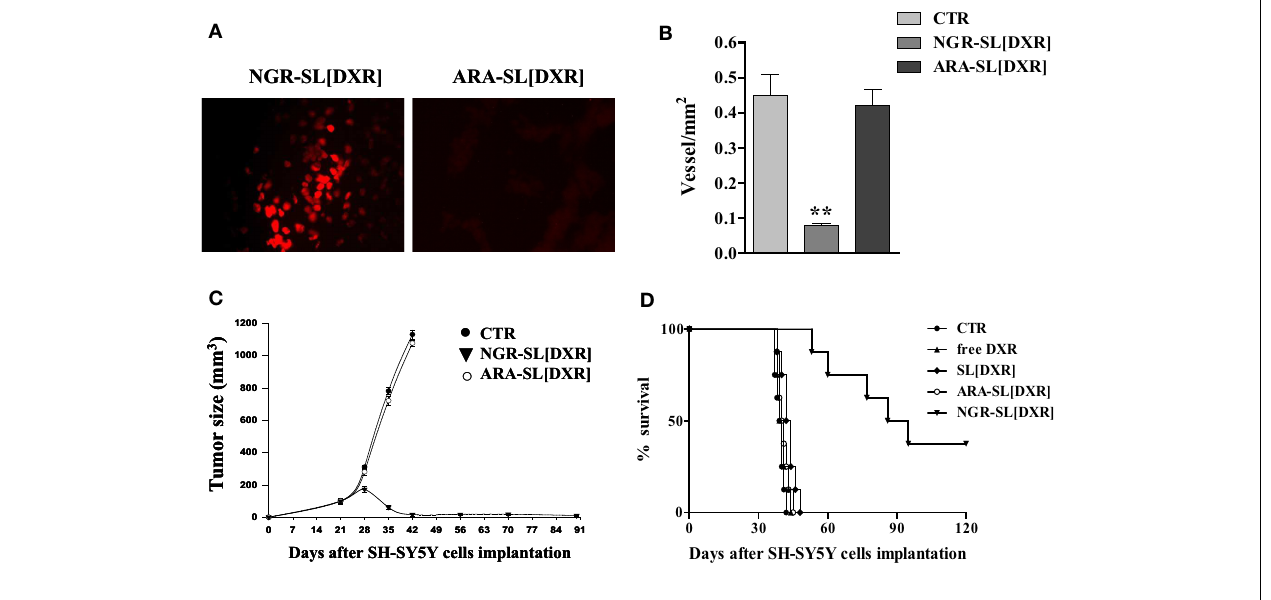
consisted of DXR administered either free (free DXR) or encapsulated in untargeted [SL(DXR)] and either NGR-targeted [NGR-SL(DXR)] or miss-matched peptide ARA-targeted [ARA-SL(DXR)] nanocarriers. Control mice (CTR) received HEPES-buffered saline. (B) Tumor vessels density inhibition after NGR-targeted liposomal DXR treatments. Orthotopic tumors, at day 36 from CTR and from both NGR- and ARA-targeted, DXR-treated groups, were sectioned and stained with an antibody to factor VIII to count blood vessels. Each bar represents the mean ± SD of five replicates. (C) Neuroblastoma tumor growth arrest by NGR-targeted liposomal DXR. Each point represents the mean ± SD of six replicates. (D) Increase in animal life span by NGR-targeted liposomal DXR. Partially reproduced from Pastorino et al.